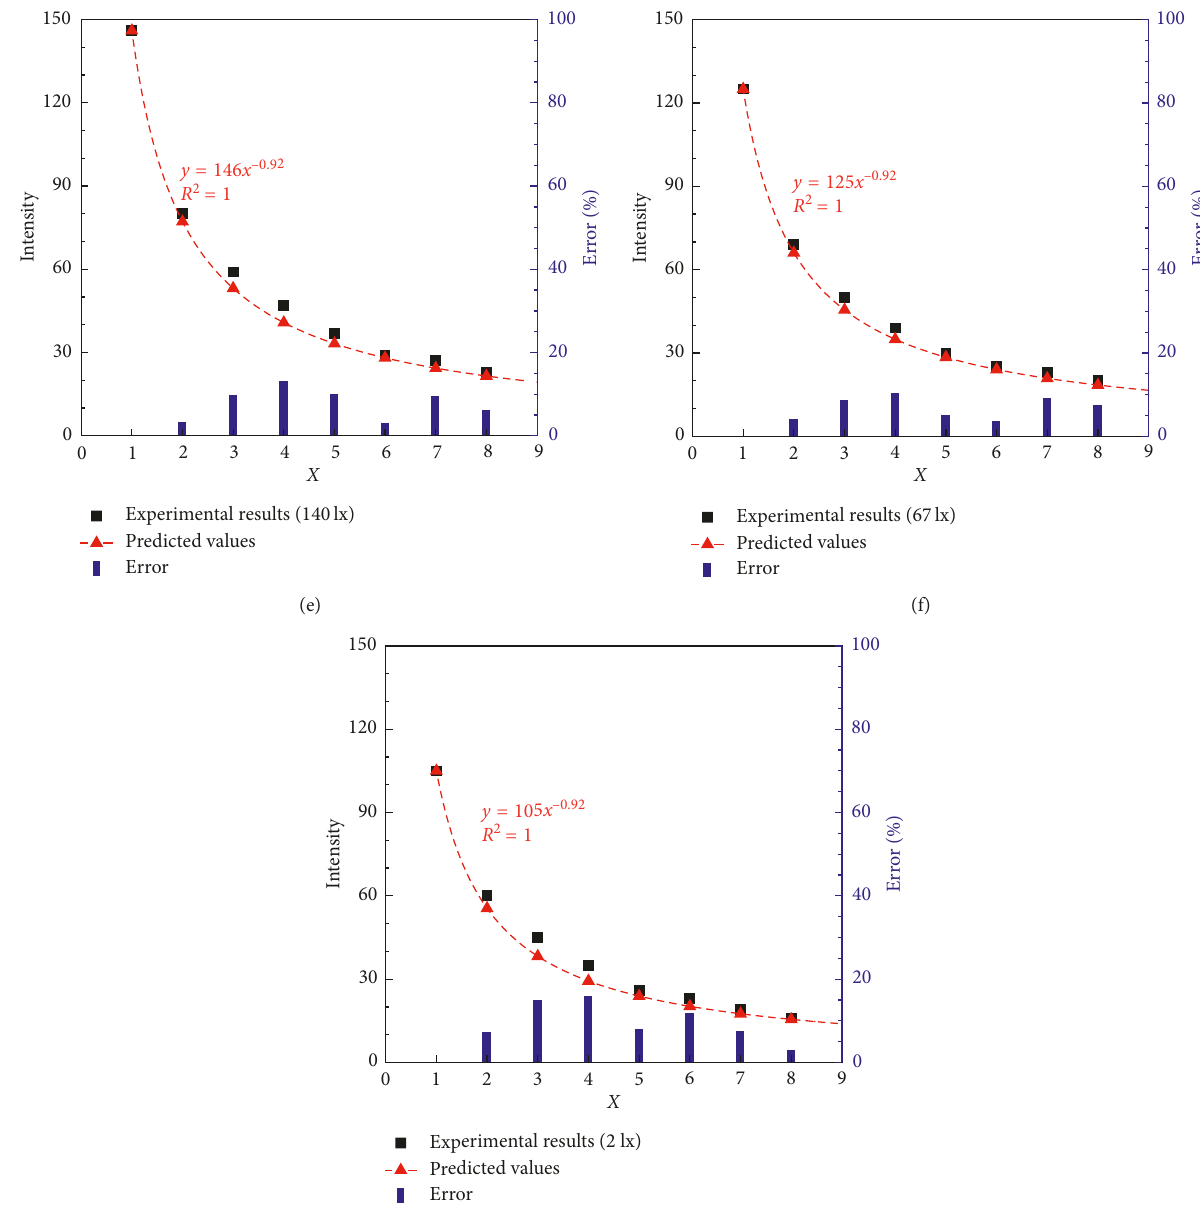
Figure 10: Plots of the experimental results for the validation of empirical